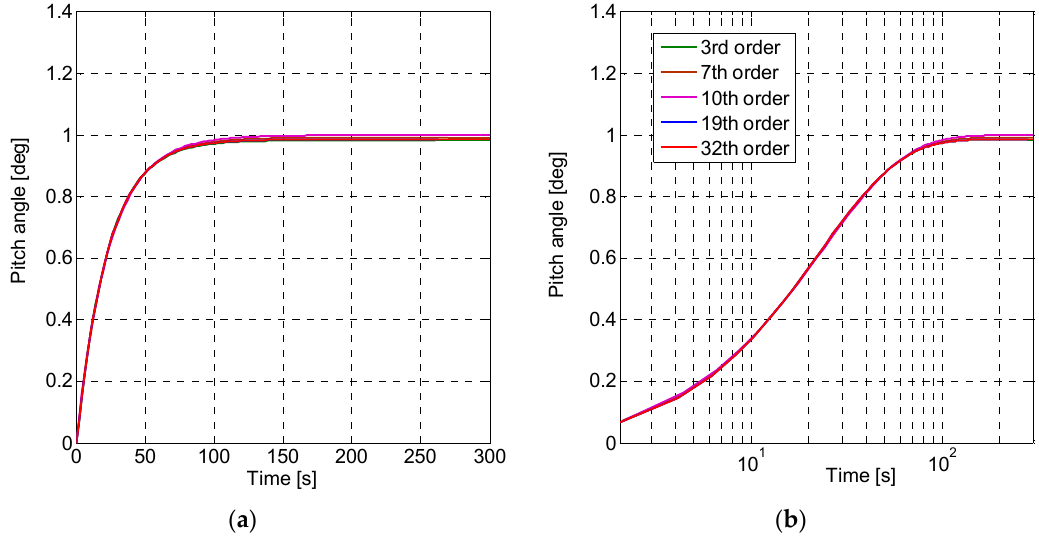
Figure 4. Step response of the closed loop system of Plant 4. Original and reduced order plants. ( a ) linear scale. ( b ) logarithmic scale.